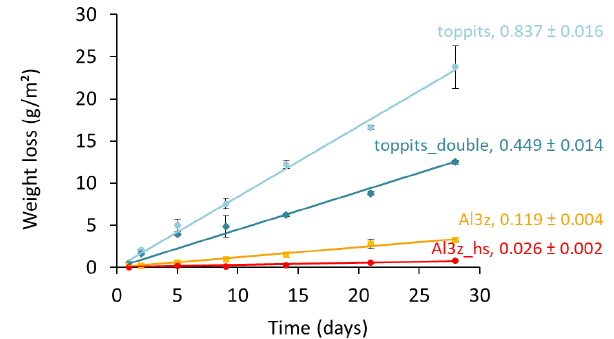
Figure 3. Time series of average weight losses normalized to the surface areas of single-layer (light-blue circles) and double- layer (blue diamonds) Toppits® freezer bags as well as zip-closed- only (orange squares) and additionally heat-sealed (red circles) Al- laminated bags. Numbers in line labels are slopes of the trend lines and indicate average weight loss rates and uncertainties in g ( m 2 d ) − 1